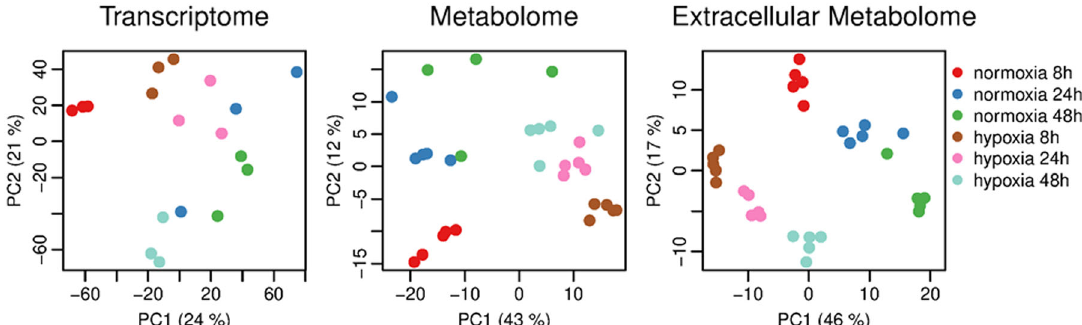
Fig. 4 Principal component analyses for transcriptome and metabolome data sets from maturing wild-type bio fi lms. Gene expression pattern from 8 h normoxic bio fi lms builds a distinct group, whereas older normoxic bio fi lms cluster together with hypoxic bio fi lms from all time points. Intra- and extracellular metabolomes strongly cluster by the oxygen state and show a mostly time-point-independent distribution. Source data are provided as a Source Data fi le.